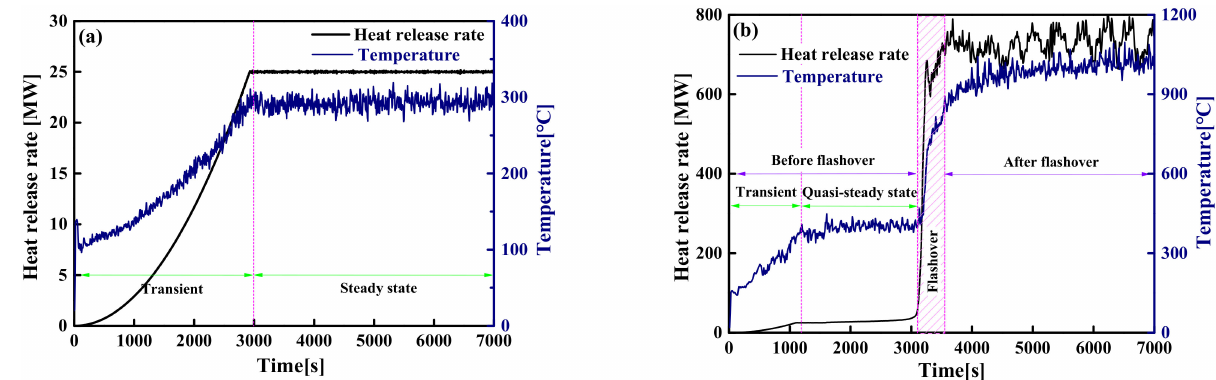
Figure 11. The evolution of the HRR and the temperature over time: ( a ) non-flashover; ( b ) flashover.